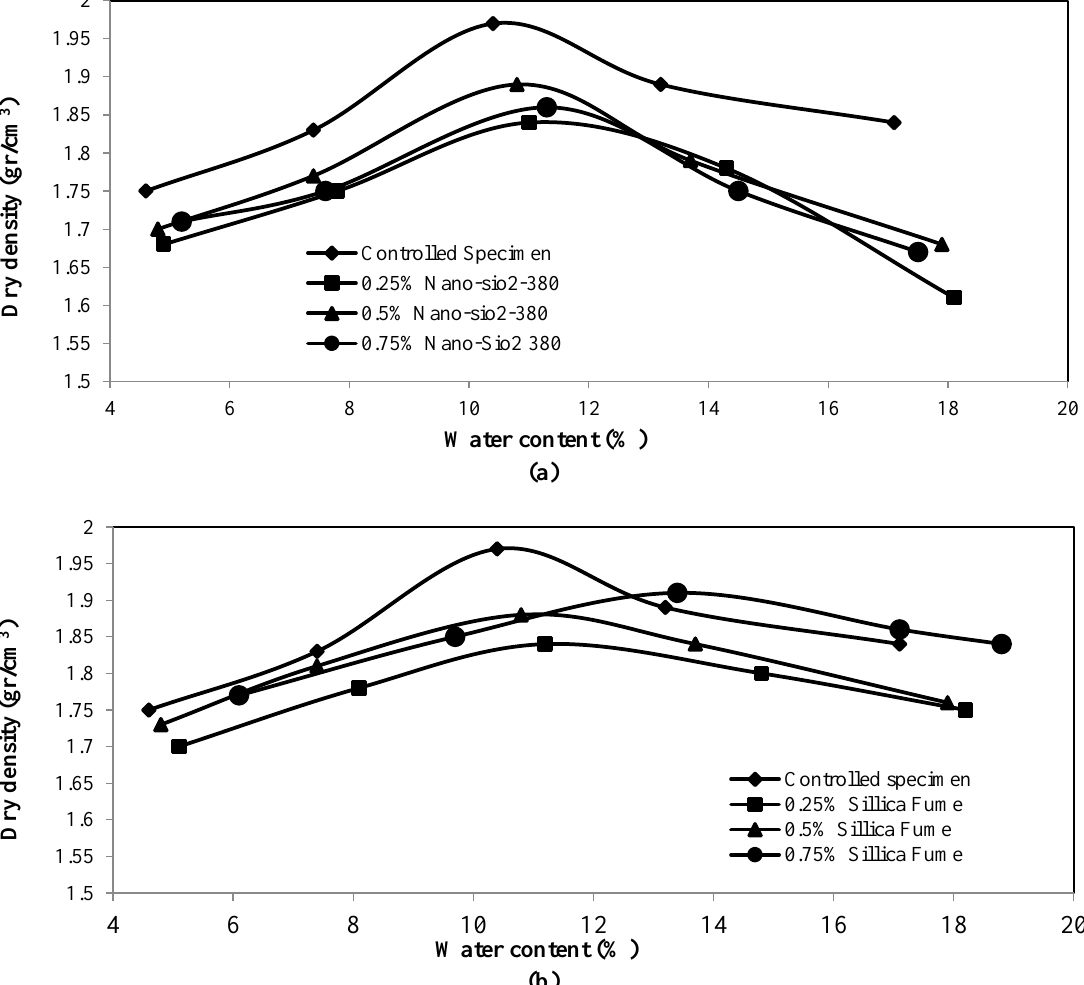
Fig. 8. The effects silica fume and nanosilica 380 on the dry density and optimum moisture content: a) Compaction curves of the mixtures containing microsilica and; b) Compaction curves of the mixtures containing nanosilica